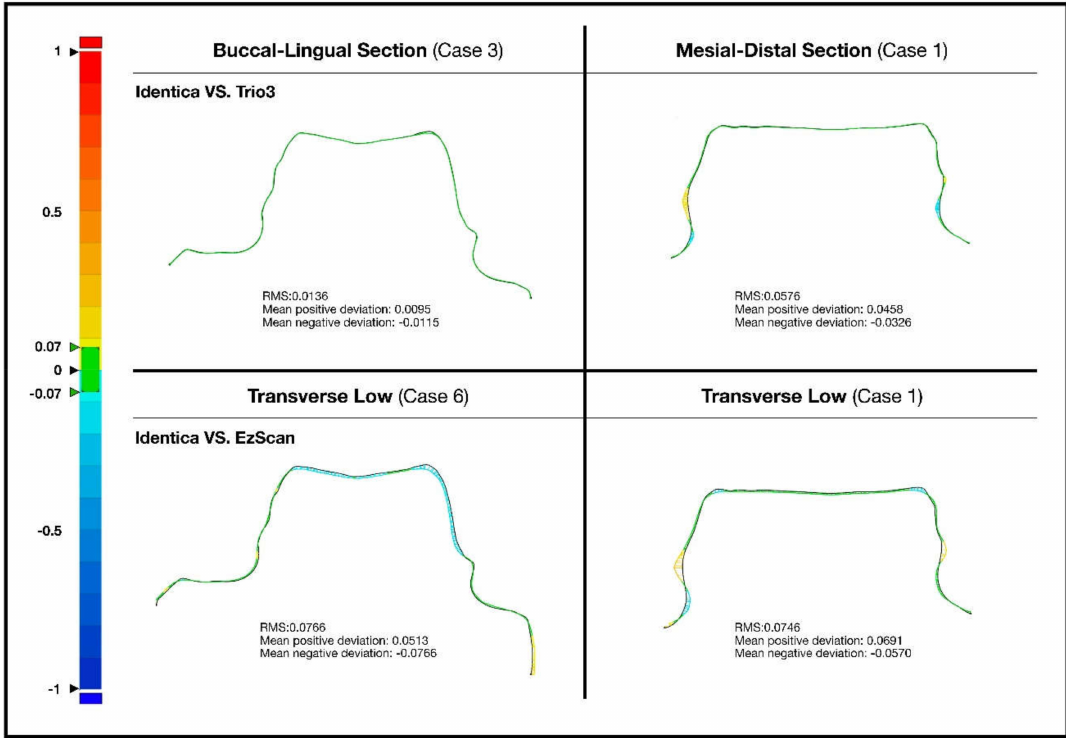
Figure 2. Comparison of the bucco-lingual section and mesial-distal section in cases with pronounced error.